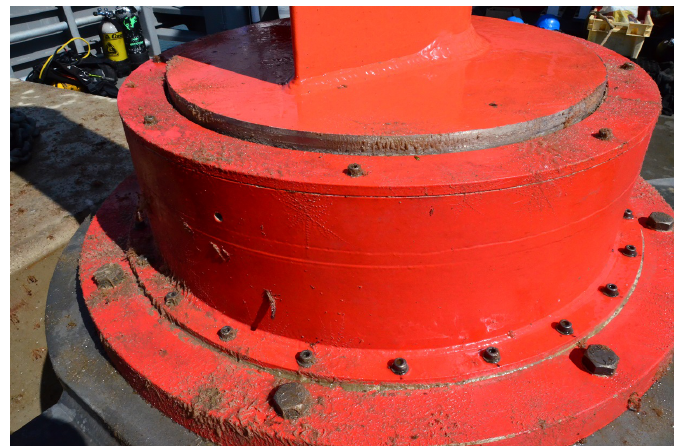
Figure 13. Biofouling formation. c (cid:13) Guinard Energies Nicolas RUIZ.